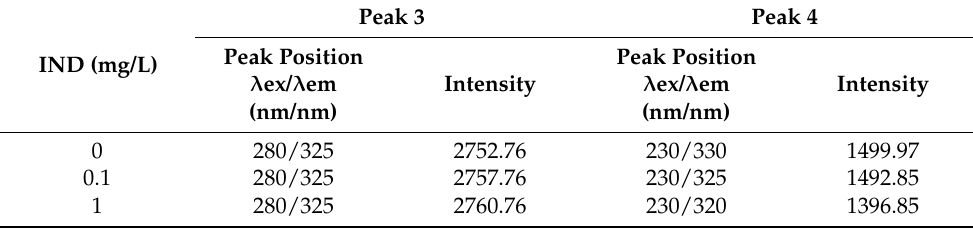
Table 2. Change information of SOD EEM fluorescence peak after combined with IND.